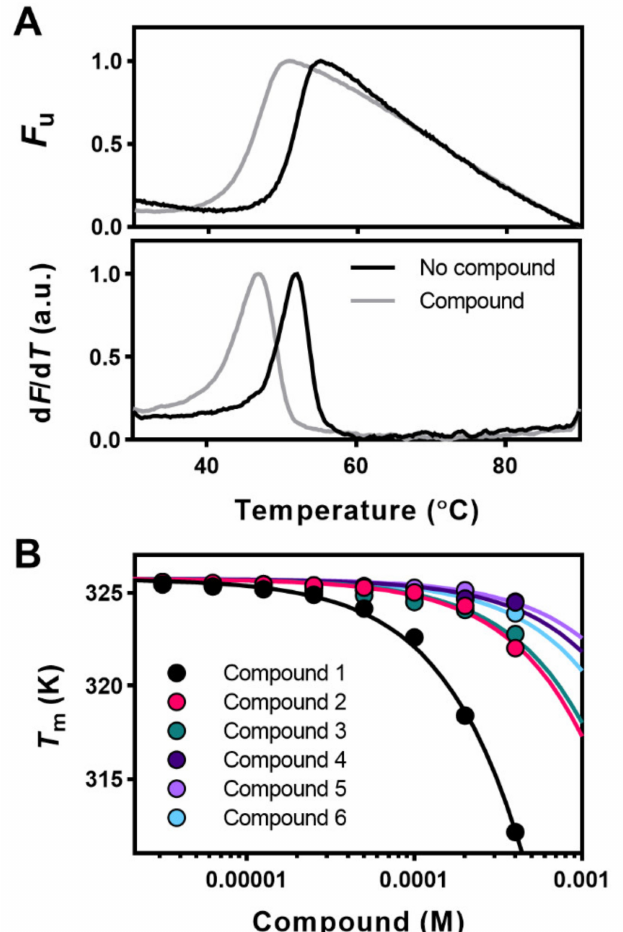
Figure 1. Thermal stability of Apg2 reflects ligand binding. ( A ) Original DSF denaturation curves (upper traces) and first derivative (bottom traces) of a destabilizing ( ∆ T m = − 3.7 ◦ C) compound. Curves obtained in the absence (reference; black line) and presence of 400 µ M of the corresponding compound (grey line). The minimum and maximum fluorescence signals were given the values of 0 and 1, respectively. ( B ) Effect of increasing ligand concentration on the midpoint denaturation temperature ( T m ) and shift of the T m of Apg2. Among the initial hits considered, compounds 1–6 induced a concentration-dependent shift of the midpoint denaturation temperature ( ∆ T m ) of Apg2. For data fitting, see Materials and Methods. The name, chemical structure, and molecular weight of these compounds are shown in Table 1 and Figure